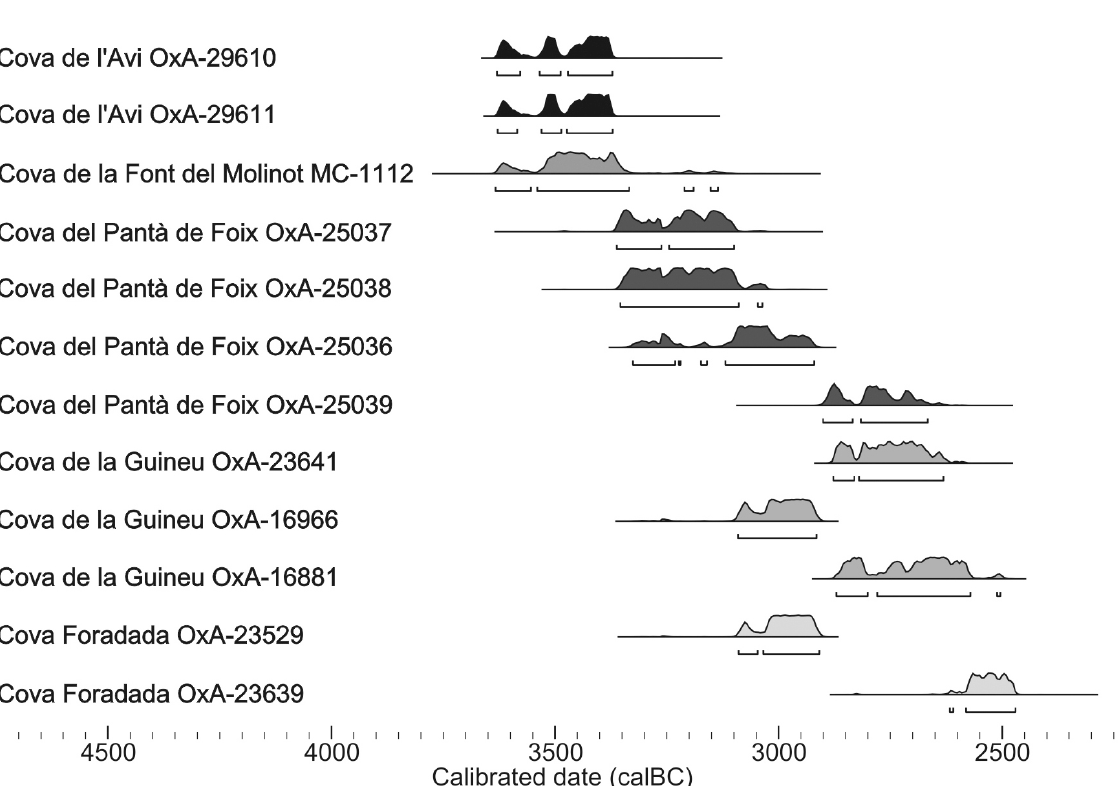
Figure 4. Calibrated results of all 14 C dates available from analysed sites in the Penedès region. Calibration with the OxCal4.2 software and the IntCal13 dataset, results shown with 2 sigma probability (Bronk Ramsey, 2013; Reimer et al.